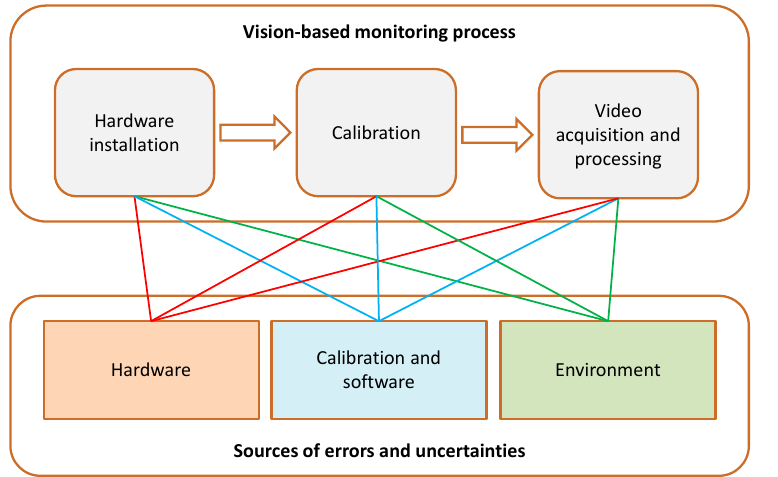
Figure 1. Diagram of the vision-based monitoring and relations with the sources of errors and uncertainties.